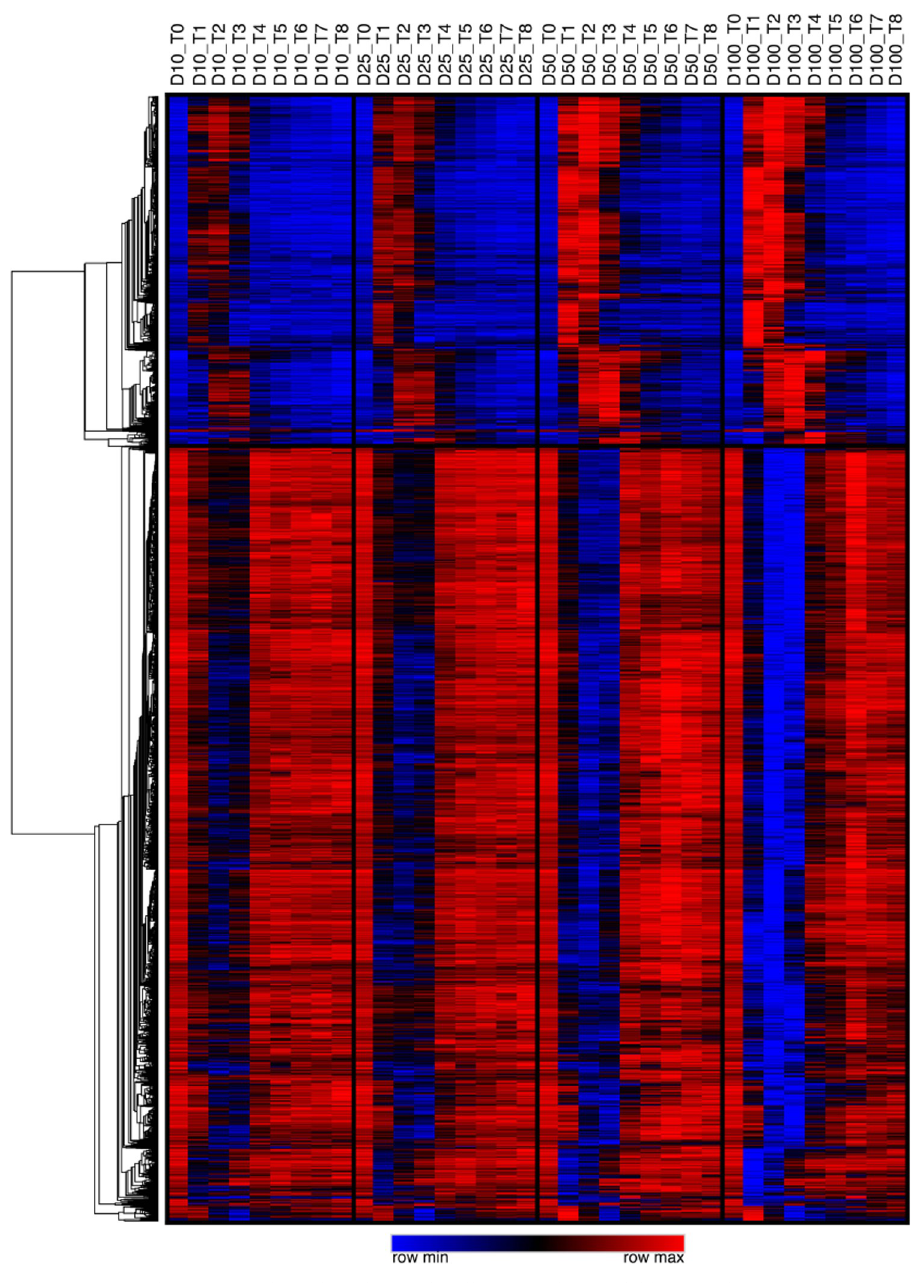
Fig 3. Heat map showing time dependent changes for all genes with a � 2-fold maximal increase or decrease in gene expression (mRNA) in response to single doses of IFN- γ . Gene expression for each gene averaged across subjects are shown in order from pre (T0) or post (T1-8) IFN- γ administration as well as by dose (10, 25, 50 and 100mcg/m 2 respectively). The cells are colored according to expression level relative to row (i.e., relative within gene). Genes that responded to IFN- γ with increased expression are at the top and those that showed decreased expression are at the